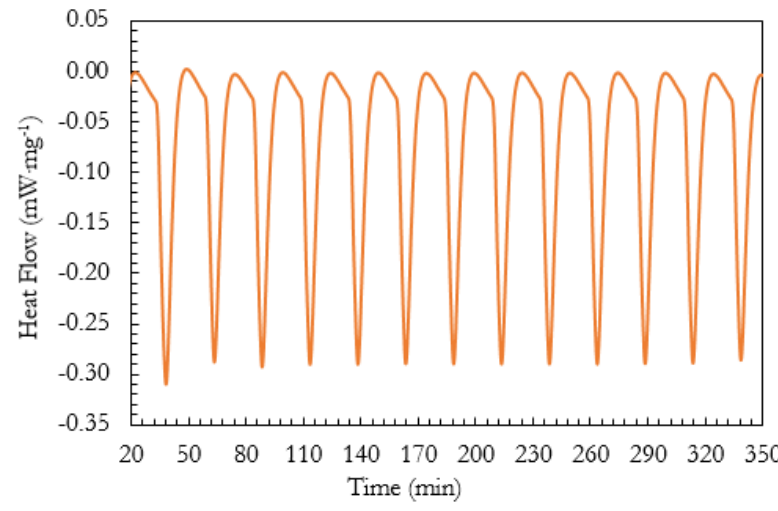
Figure 4. Heat flow over time for the EC-PCM40-BN10 sample for 12 cycles. Figure 4 . Heat flow over time for the EC-PCM40-BN10 sample for 12 cycles .